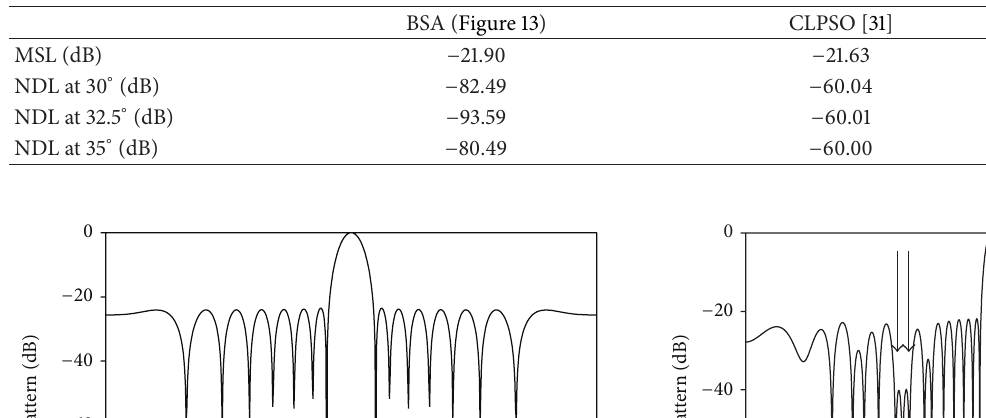
Table 7: MSL and NDL values obtained by BSA and other optimization techniques CLPSO [31] and MVMO [43] for 28-element linear antenna array with imposed triple null at 30 ∘ , 32.5 ∘ , and 35 ∘ .